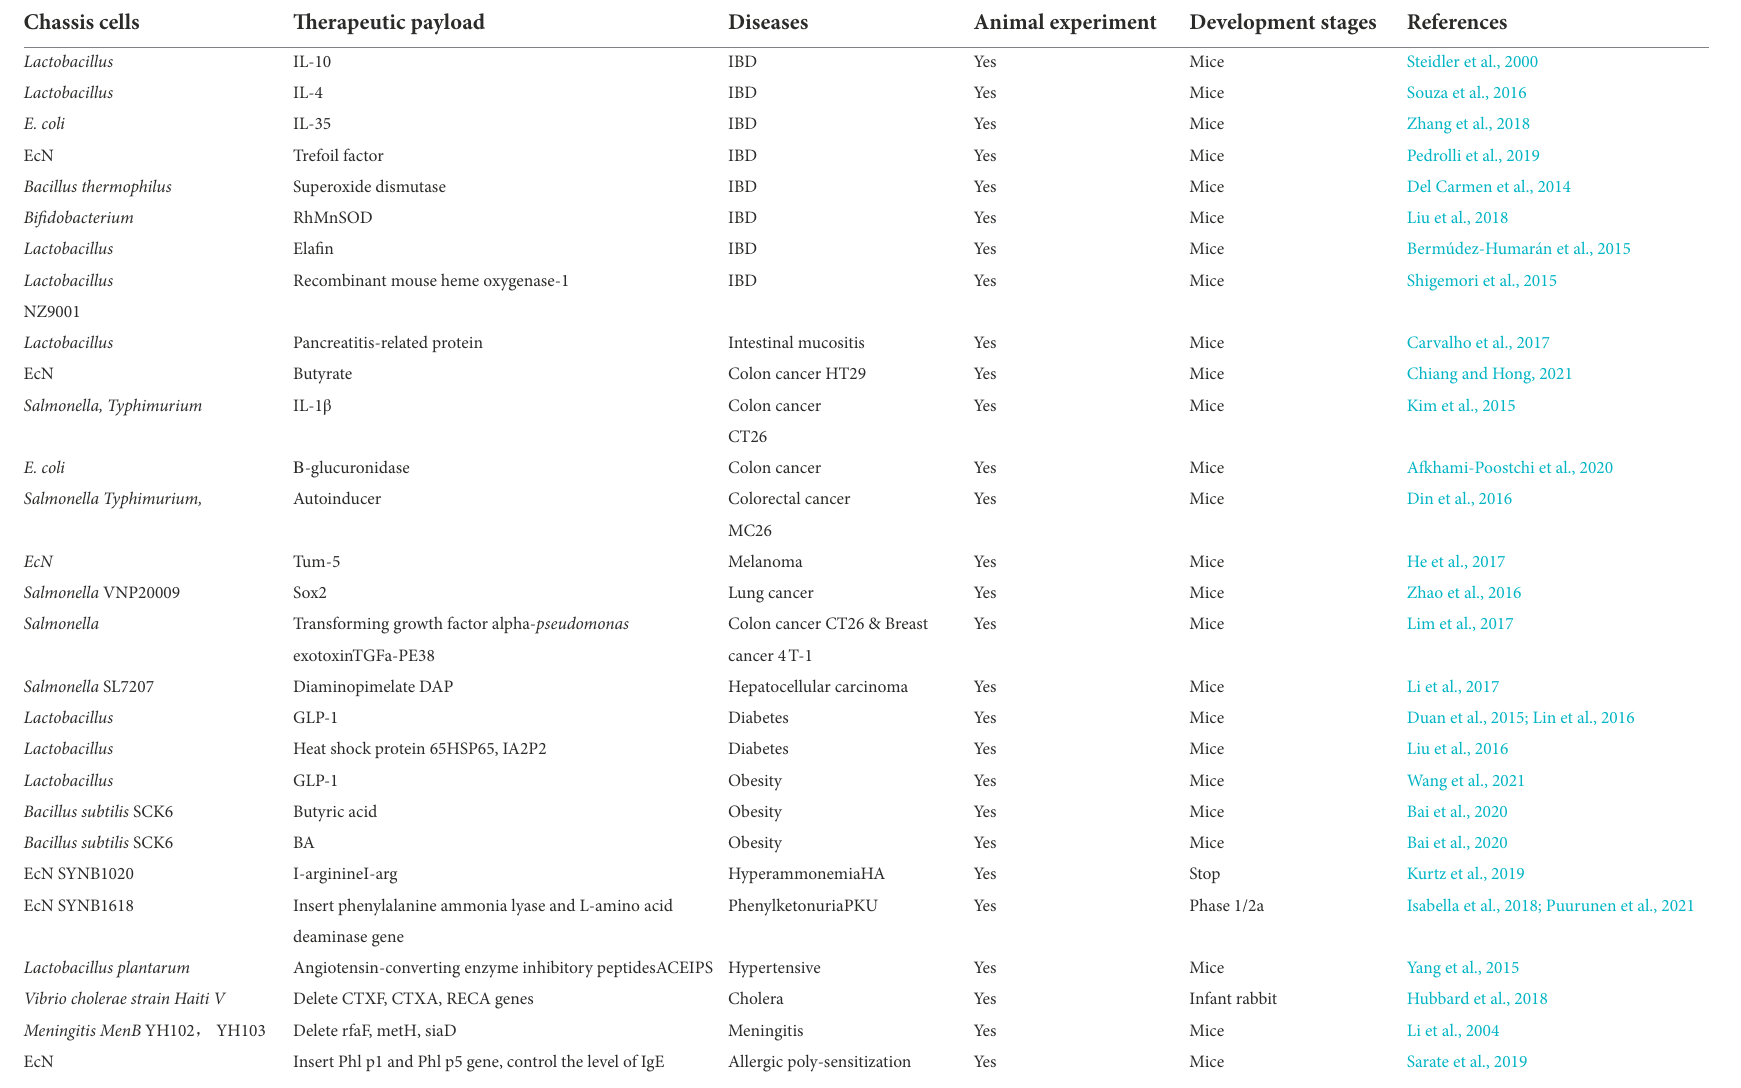
TABLE 1 Use of GEBs in disease